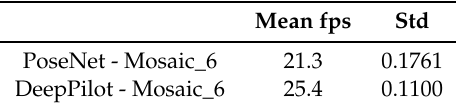
Figure 18. Top view ( a ) and side view ( b ) of the performance of our proposed DeepPilot, trained to predict the 4 flight commands ( φ , θ , ψ , h ) , for 10 runs in the zigzag track, each run was successful. The average time for the drone to complete the track was 2 min 31 s and the command prediction output ran at 25 fps. Table 6. Mean processing time expressed in frames per second (fps) and its standard deviation (Std) for PoseNet [6] and DeepPilot in the zigzag racetrack. A mosaic image composed of 6 frames was used as